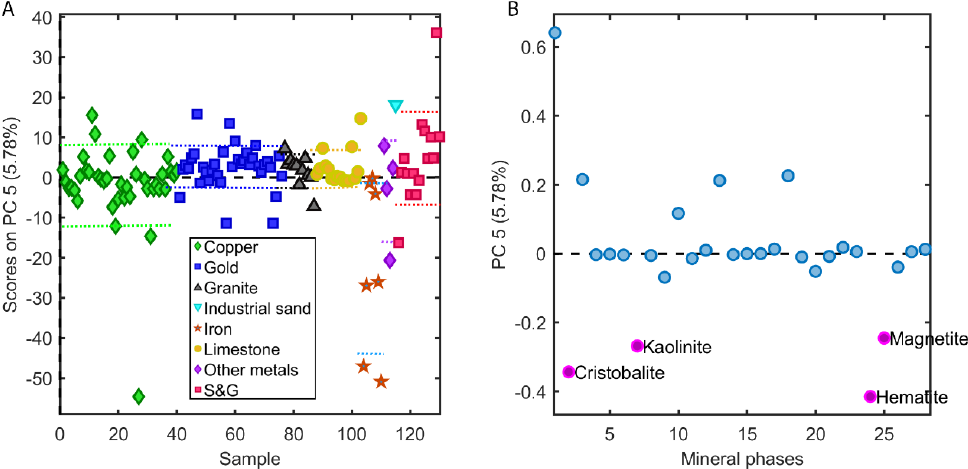
Figure 4. PCA results of XRD mineralogy data ( A ) Sample scores PC5 v. sample number; ( B ) Loadings v. mineral phases on PC5.